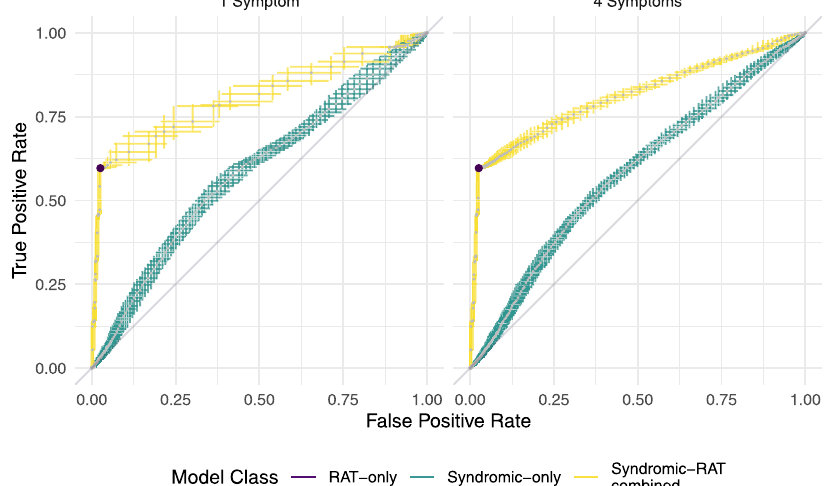
Fig. 2 Generic model classi fi cation performance. Median (grey dots) and interquartile ranges for receiver operating characteristics (ROC) for rapid antigen testing only approach (purple) and posterior median and interquartile range ROC for Syndromic-only (teal) and Syndromic-Rapid Antigen Test (RAT) Combined (yellow) models for n = 1172 biologically independent individuals predicted under temporally structured cross-validation. In the RAT-only model, the ROC is a single value (i.e., a dot rather than a line) as the binary test has a single sensitivity and speci fi city. In Syndromic-only and Syndromic- RAT Combined classes, the ROC values demonstrate the performance of the model for any hypothetical scenario as de fi ned by the axes (as opposed to Fig. 5 which demonstrates model performance in speci fi c epidemiological scenarios which are realisations of single points in this space). While ROC plots are often plotted as curves, we do not have continuous probability values due to the binary nature of predictor symptoms. This is important as discontinuity in the probabilities impacts the sensitivity of the model to classi fi cation thresholds, such as those used in the scenarios worst, and Syndromic-RAT Combined achieved the lowest error, for each scenario-model combination can be translated into with RAT-only falling between the two (closer to Syndromic-RAT numbers of misclassi fi cations per 1000 tests if the test positivity Combined than Syndromic-only). The error in RAT-only was 0.03 rate is known. We present this in Supplementary Results and the median errors ranged from 0.19 to 0.2 for Syndromic-only, (Supplementary Results Table 1) for low (5%), average (20%) and and 0.19 to 0.2 for Syndromic-RAT Combined (Fig. 3). The results high (35%) test positivity rates in Bangladesh.